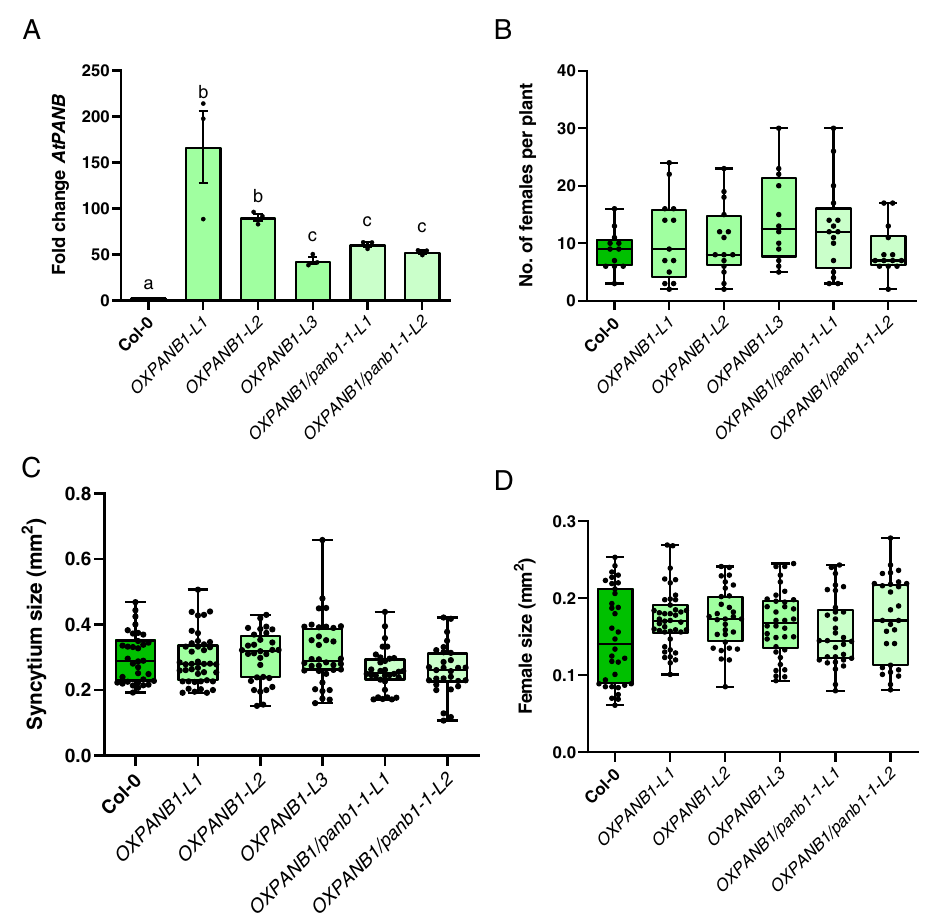
Fig. 8 | Overexpression of AtPANB1 restores susceptibility to cyst nematodes. A Quantitative reverse transcription-polymerase chain reaction (qRT-PCR) con- fi rmationof the increase in AtPANB1 transcript in overexpression linesof the Col-0 ( OXPANB1 lines L1, L2, L3) or atpanb1-1 ( OXPANB1/panb1-1 lines L1 and L2) back- ground. Bars represent mean±SE. Data were analysed using a one-way analysis of variance (ANOVA) followed by Tukey ’ s HSD post hoc test ( α =0.05). Experiments were repeated three times independently ( n =3) and different letters indicate sig- ni fi cantlydifferent means. AtPANB1 transcript levels were signi fi cantlyincreased in comparison to all tested lines ( p <0.001). B Number of female cyst nematodes presentperplantrootsystemat14dpi(Col-0, n =12; OXPANB1-L1 , n =13; OXPANB1- L2, n =15; OXPANB1-L3, n =12; OXPANB1/panb1-1-L1 , n =16; OXPANB1/panb1-1-L2 , n =14). C Size of syncytia at 14 dpi. Female-associated syncytia were randomly